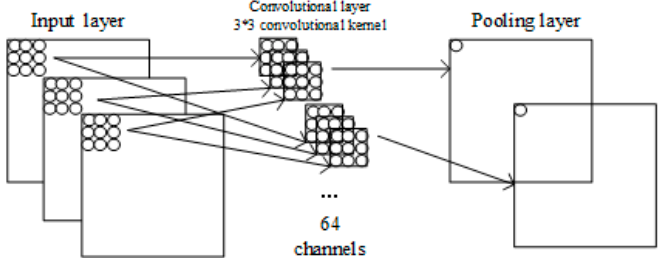
Figure 3. Variation of standard convolution compared to MobileNet convolution.